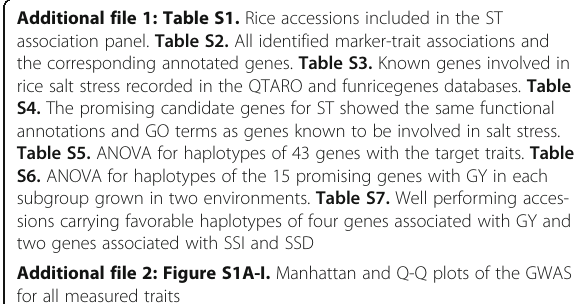
Additional file 1: Table S1. Rice accessions included in the ST association panel. Table S2. All identified marker-trait associations and the corresponding annotated genes. Table S3. Known genes involved in rice salt stress recorded in the QTARO and funricegenes databases. Table S4. The promising candidate genes for ST showed the same functional annotations and GO terms as genes known to be involved in salt stress. Table S5. ANOVA for haplotypes of 43 genes with the target traits. Table S6. ANOVA for haplotypes of the 15 promising genes with GY in each subgroup grown in two environments. Table S7. Well performing acces- sions carrying favorable haplotypes of four genes associated with GY and two genes associated with SSI and SSD Additional file 2: Figure S1A-I. Manhattan and Q-Q plots of the GWAS for all measured traits Abbreviations 3 K RGP: 3K Rice genome project; ANOV: Analysis of variance.; FGN: filled grain number.; GAPIT: Genome Association and Prediction Integrated Tool.; GO: gene ontology.; GWAS: Genome-wide Association Study.; GY: grain yield per plot.; HD: heading date.; MAF: minor allele frequency.; QTL: quantitative trait loci.; SNP: single nucleotide polymorphism.; SSD: seedling survival days.; SSI: salt stress injury.; SSR: seed setting rate.; ST: salt tolerance.; SN: seedling number.; TGW: thousand-grain weight.; TPN: total panicle number.; TSN: total spikelet number per